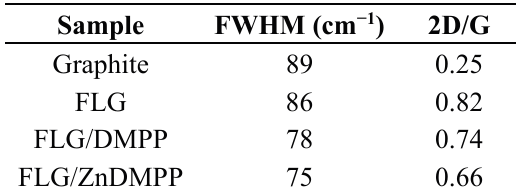
Figure 5. Raman spectra (mean of five separate measurements) of graphite (black) and FLG in NMP (red), FLG/DMPP (green) and FLG/ZnDMPP (blue) after exfoliation during 240 min. Cross symbols represent the single Lorentzian fit of the 2D band. Table 1. Full-width at half maximum (FWHM) and 2D/G ratio of graphite, FLG and FLG/porphyrin